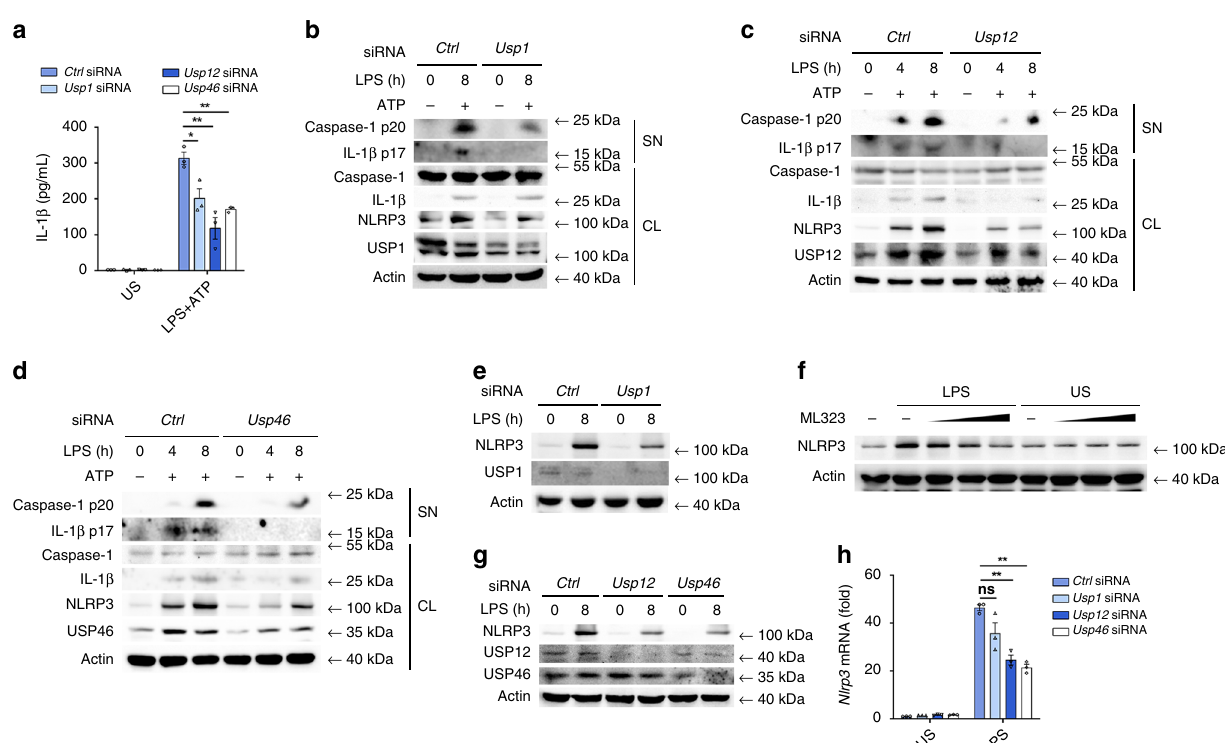
Fig. 3 USP1, USP12, and USP46 enhance NLRP3 in fl ammasome activation. a – d ELISA analysis of IL-1 β secretion ( a ) and western blot analysis of caspase- 1 and IL-1 β cleavage ( b , d ) in Ctrl siRNA-, Usp1 siRNA-, Usp12 siRNA-, or Usp46 siRNA-transfected mouse peritoneal macrophages followed by priming with LPS for 8 h ( a ) or indicated time periods ( b – d ), and then stimulated with ATP for 40 min (mean ± SEM, two-tailed t -test Usp1 siRNA, Usp12 siRNA and Usp46 siRNA vs. Ctrl siRNA, * P = 0.0238, ** P = 0.0049, 0.0013 in sequence; n = 3 independent experiments). e , g Western blot analysis of NLRP3 expression in Ctrl siRNA-, Usp1 siRNA-, Usp12 siRNA-, or Usp46 siRNA-transfected mouse peritoneal macrophages after stimulation with LPS for 8 h. f Western blot analysis of NLRP3 expression in mouse peritoneal macrophages treated with DMSO or increasing amount of ML323 (0, 15, 30, and 60 μ M) followed by stimulation with LPS for 8 h. h RT-PCR analysis of Nlrp3 mRNA expression in Ctrl siRNA-, Usp1 siRNA-, Usp12 siRNA-, or Usp46